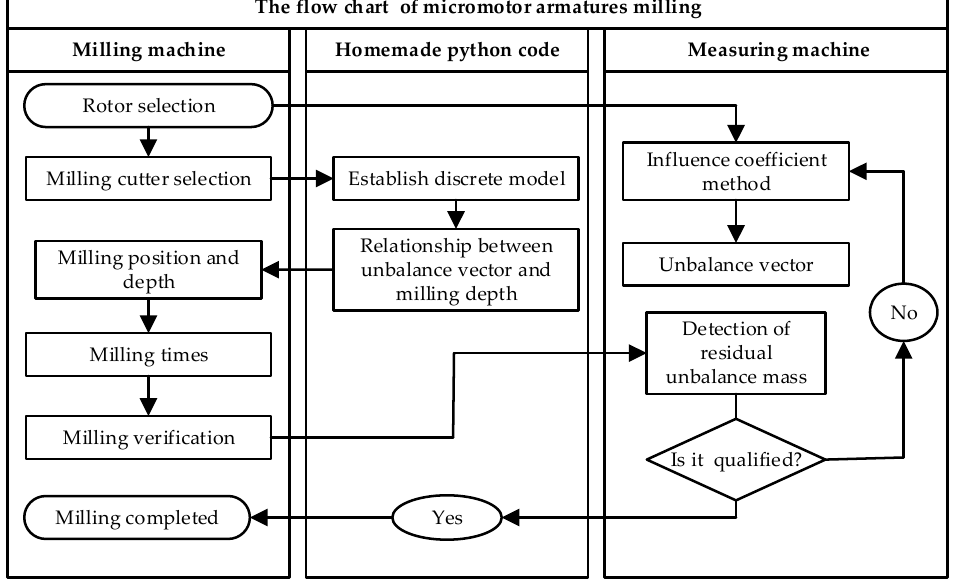
Figure 12. The flow chart of micromotor armatures milling.